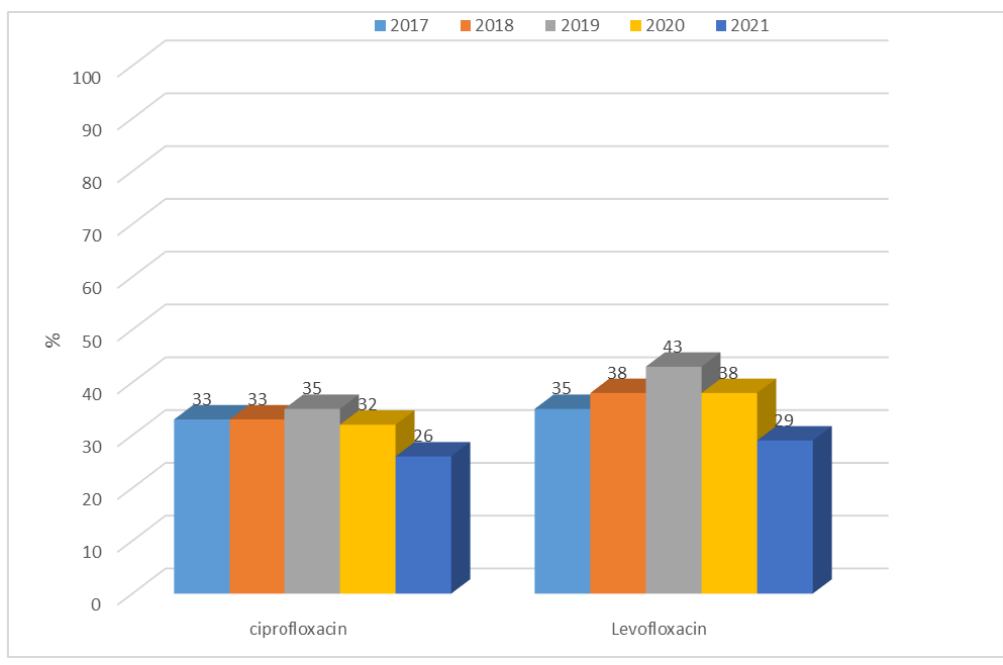
Figure 9. Percentage of quinolone-resistant E. coli ESBL(−) strains.